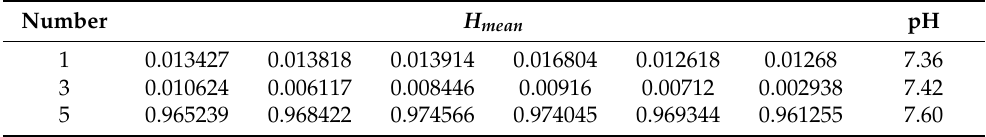
Table 5. H mean and pH value measured by pH meter of orifice plate images of 6-well liquid collected at different